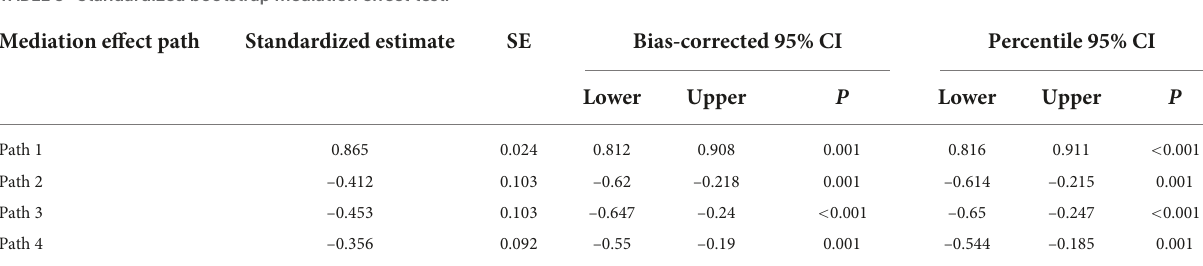
TABLE 5 Standardized bootstrap mediation effect